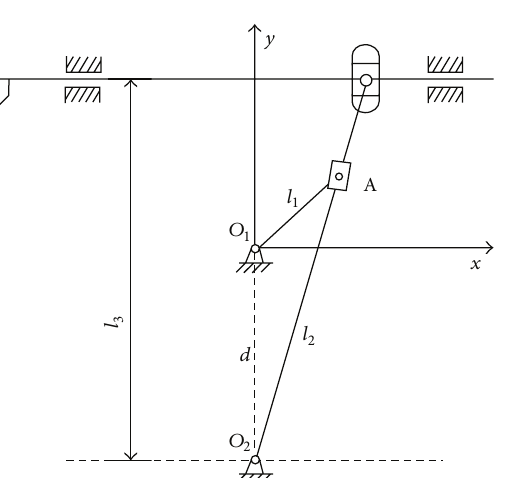
Figure 6: The shaper mechanism